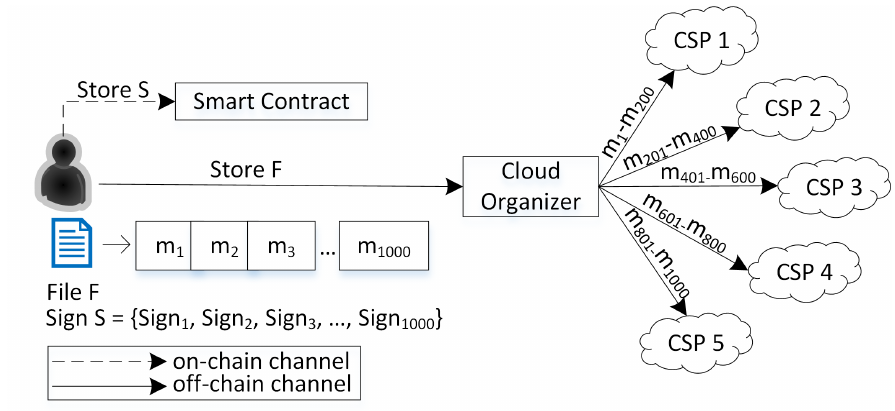
Figure 1. Scenario example of the proposed